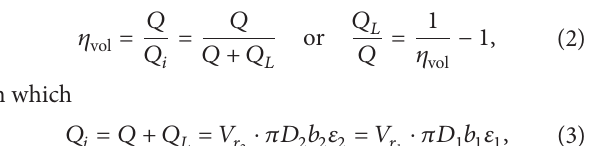
Figure 2: Velocity diagram at impeller